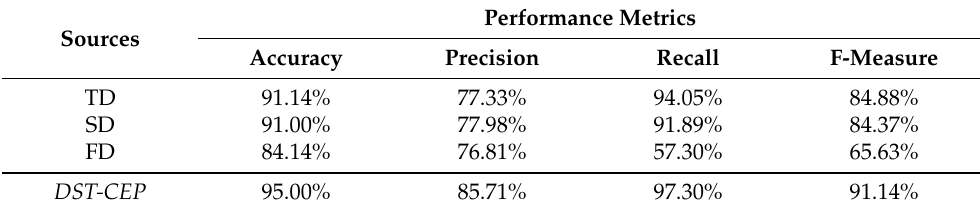
Table 4. Results of performance metrics from individual